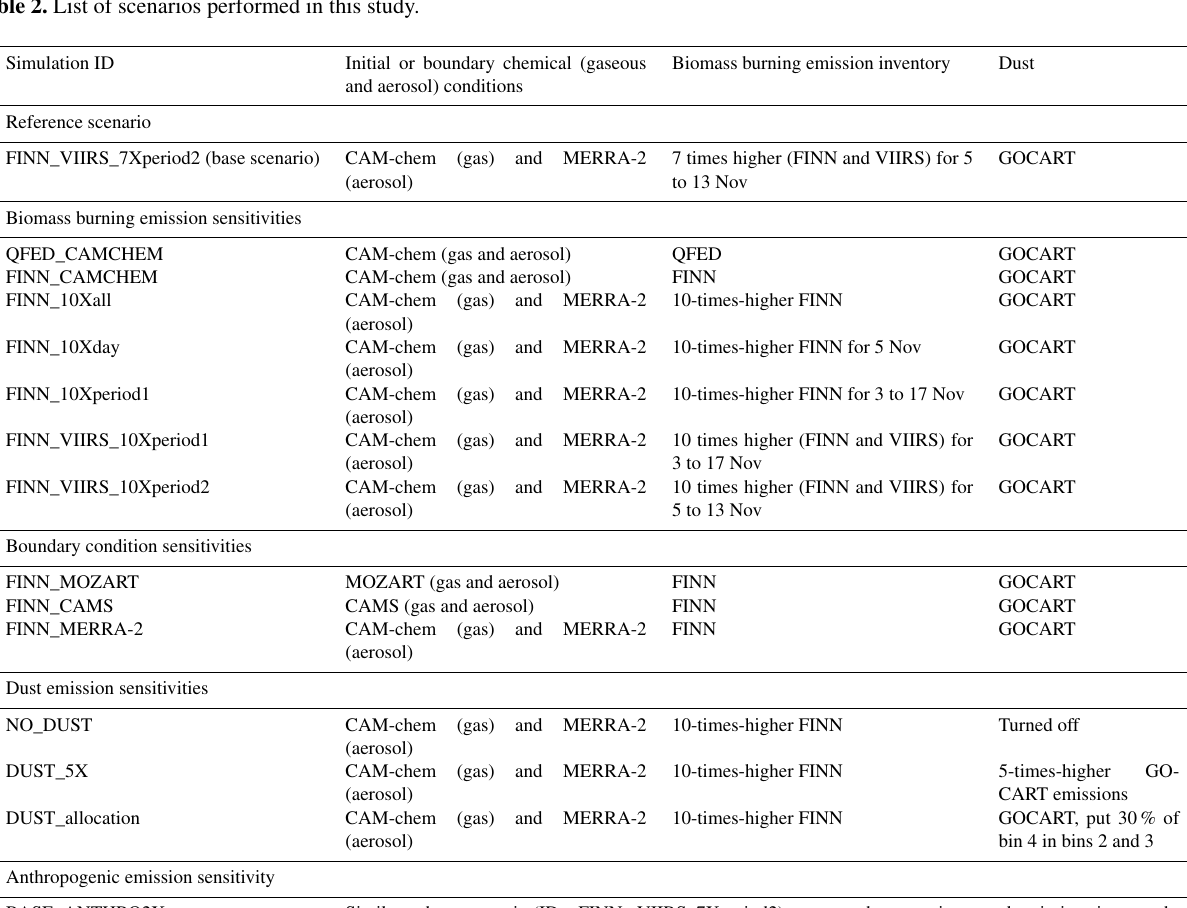
Table 2. List of scenarios performed in this